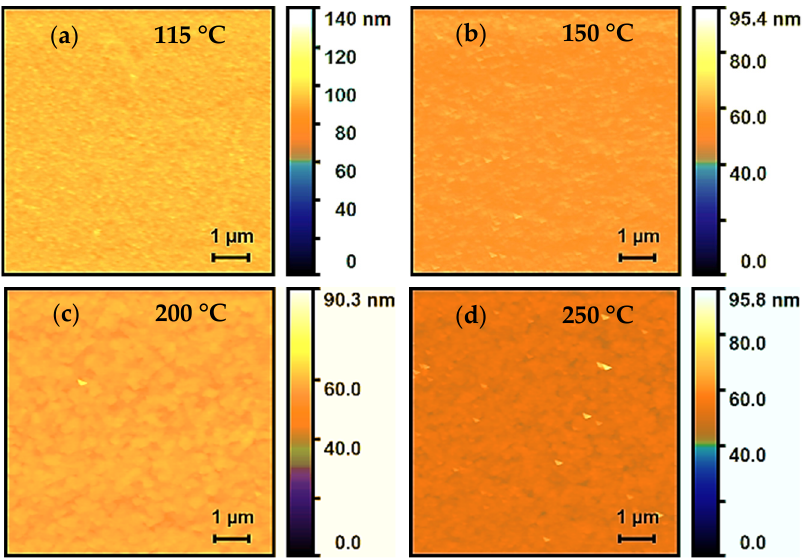
◦ C, ( b ) 150 ◦ C, ( c ) 200 ◦ C, and ( d ) 250 ◦ Figure 4. AFM images of In 2 O 3 films deposited at ( a ) 115 ° C, ( b ) 150 ° C, ( c ) 200 ° C, and ( d ) 250 ° C. Figure 4. AFM images of In 2 O 3 films deposited at ( a ) 115